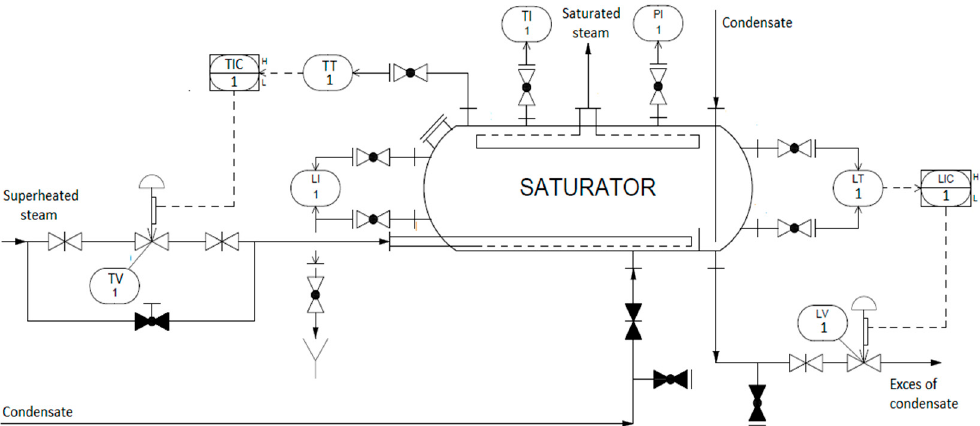
Figure 2. The practical diagram implemented for the temperature control [14].